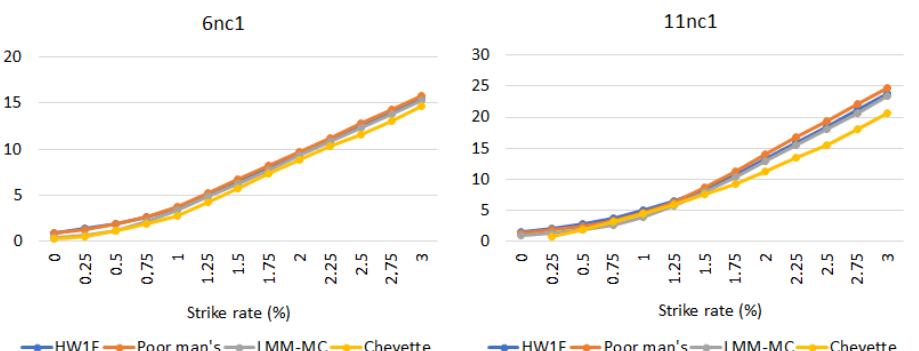
Figure 10. Model prices of a 6nc1 (lhs panel) and 11nc1 (rhs panel) Bermudan receiver swaptions with 100